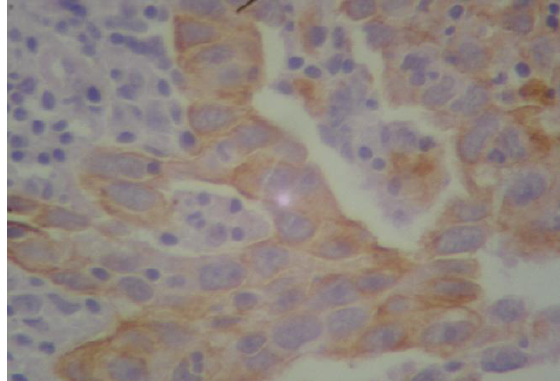
Fig 1. Immunohistochemical staining of cytokeratin 7 expression in colon adenocarcinoma.